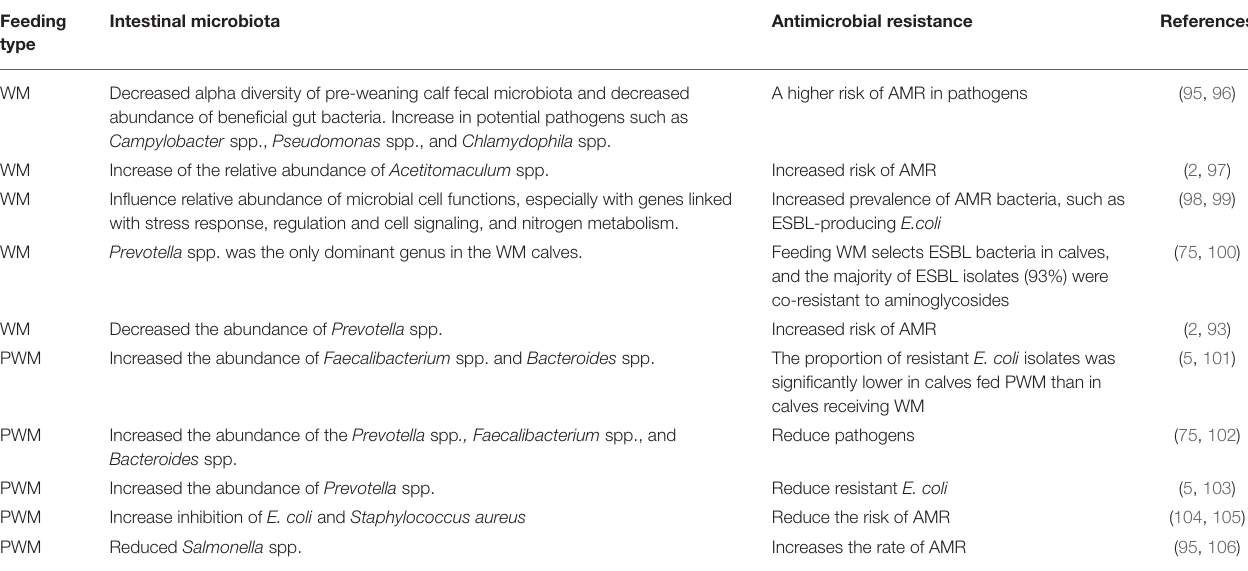
TABLE 2 | Raw WM and PWM effect on the intestinal microbiota and antimicrobial resistance of calves. Feeding Intestinal type